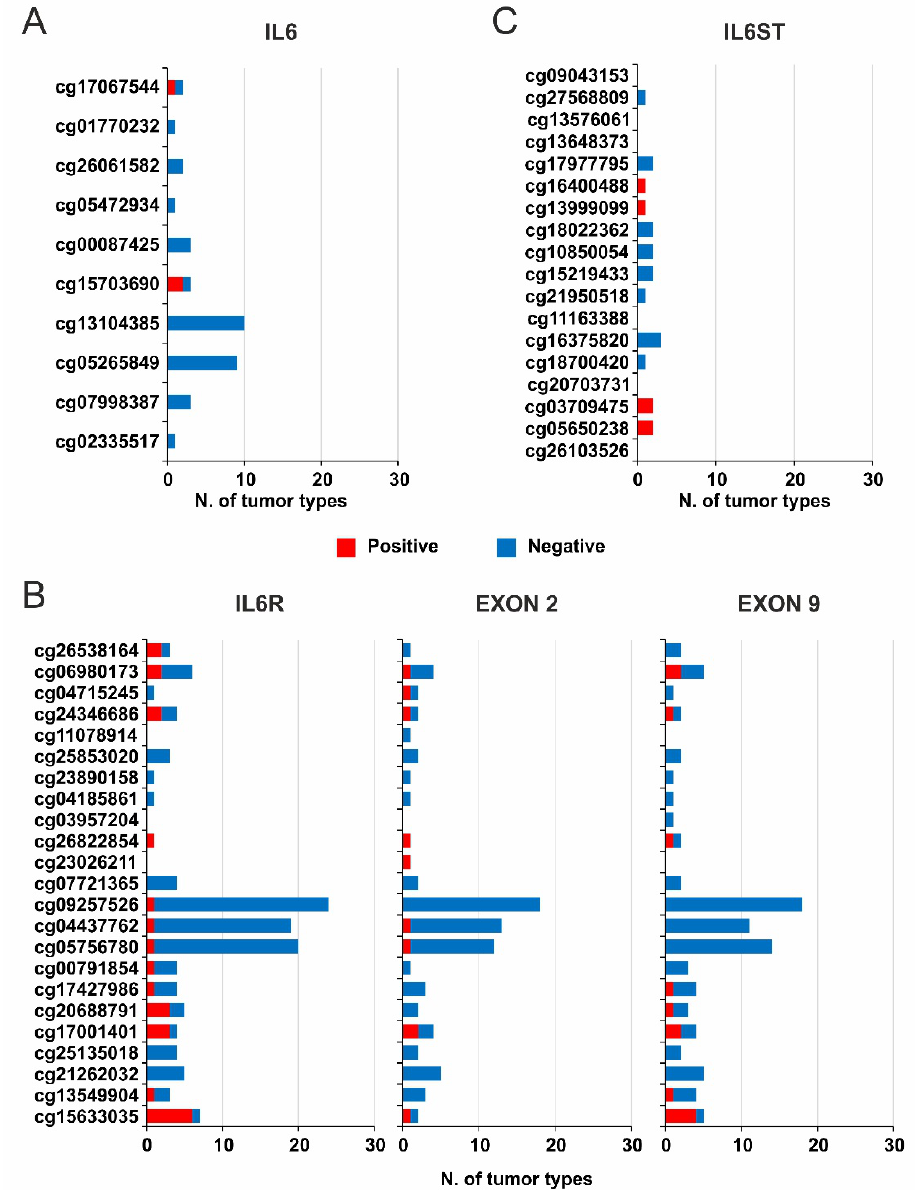
Figure 2. Overview of correlation analysis between IL6, IL6R, and IL6ST gene expression and CG probesets methylation. The number of CG probesets of IL6 ( A ), IL6R, IL6R Exon 2 and 9 ( B ), and IL6ST ( C ) showing Pearson’s r ≤ − 0.3 or ≥ 0.3 ( p ≤ 0.05) was evaluated in all TCGA tumor types.